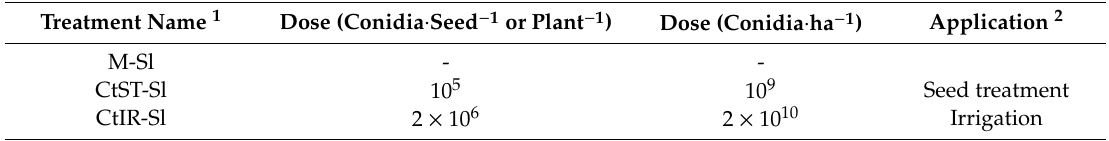
Table 2. Experimental design for the greenhouse tomato